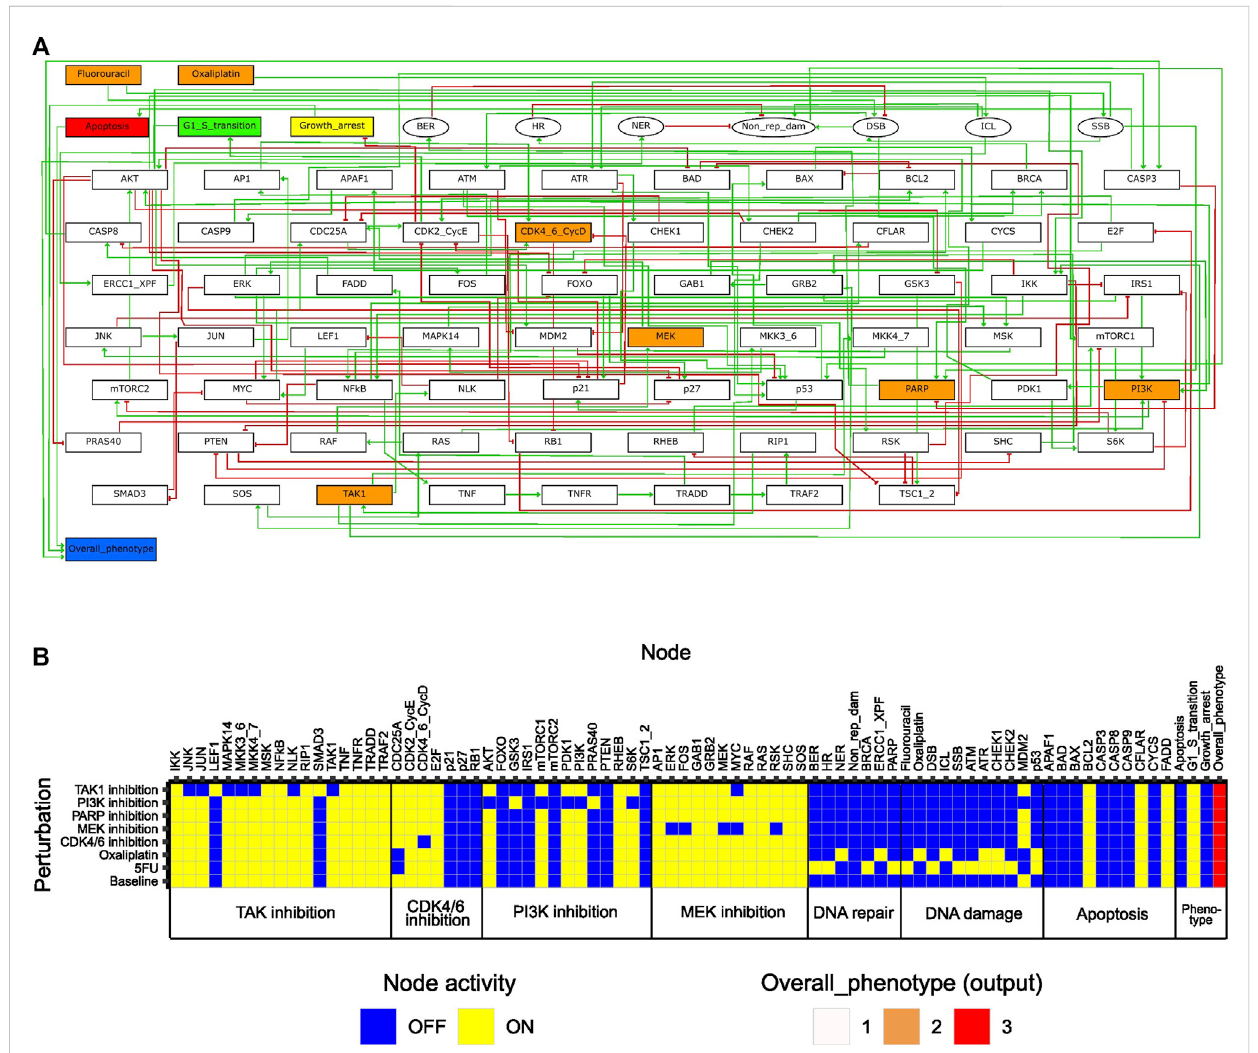
FIGURE 2 Features of the initial logical model. (A) Model topology; green arrows and red bar-headed lines indicate activation and inhibition, respectively. Orange rectangular nodes correspond to drugs (Fluorouracil/5FU, Oxaliplatin) or drug targets (MEK, PI3K, CDK4_6_CycD, TAK1, PARP; also signaling molecules).Whiterectangularnodescorrespondtoothersignalingmolecules.Ellipticnodescorrespondtophenotypesorcellulareventsassociatedwith DNAdamageand repair. Nodes representing phenotypes apoptosis,growth arrest,G1/S transitionandoverallphenotype arecoloredinred,yellow, green,andblue,respectively. (B) Stablestates(row-wise)computedwiththeinitialmodelforallindividualdrugperturbations(single-drugeffect),andfor the unperturbed (baseline) model. Nodes are categorized based on their association with either a drug target or a phenotypic